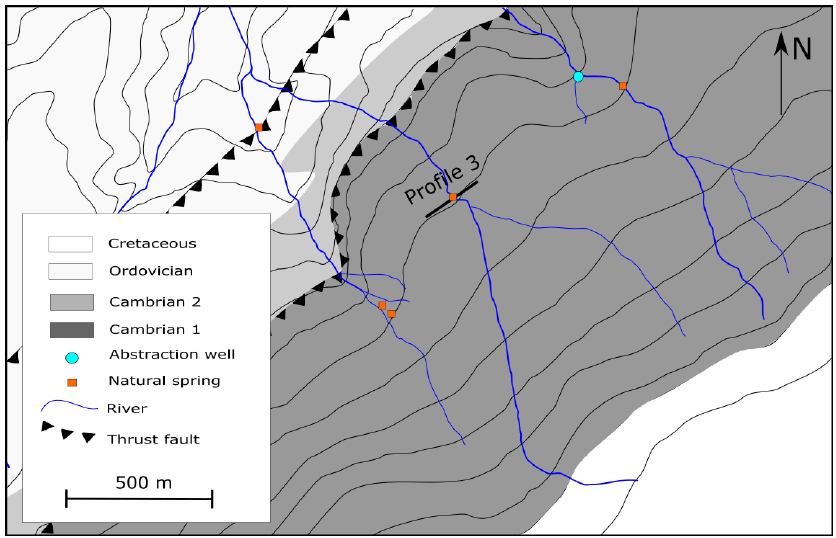
Figure 5. Localisation of Profile 3 in the second studied